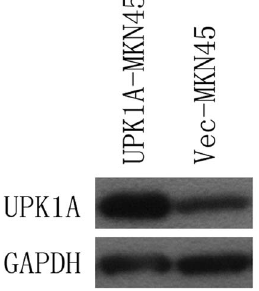
Figure 8. UPK1A expression in the UPK1A-transfected MKN45 cell line (UPK1A-MKN45) was detected by WB. Empty vector- transfected cells (Vec-MKN45) were used as control.